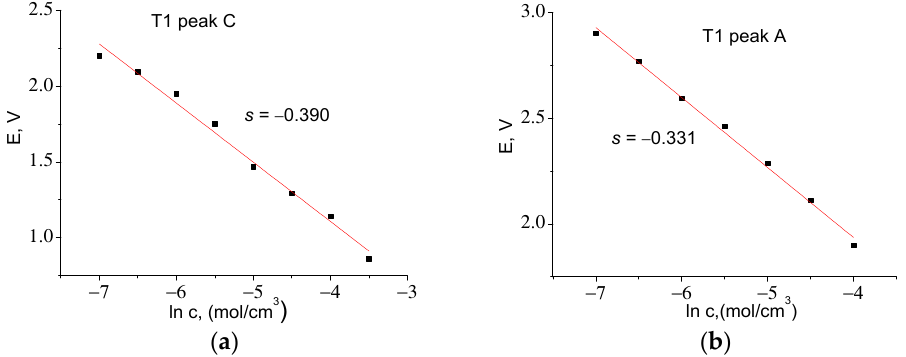
Figure 11. Experimental dependences of E = f(ln c ) for T1 series samples for: ( a ) cathodic ( z = 0.066) and ( b ) anodic ( z = 0.078) parts of CVA.